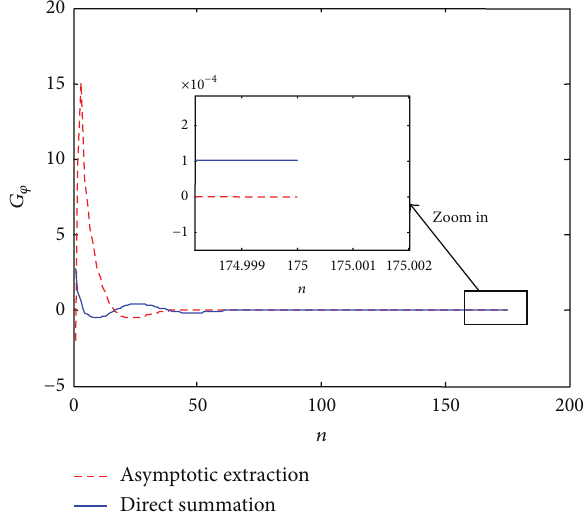
Figure 8: Convergence of 𝐺 21 𝜑 when source is located in the probe and field locate in the patch.